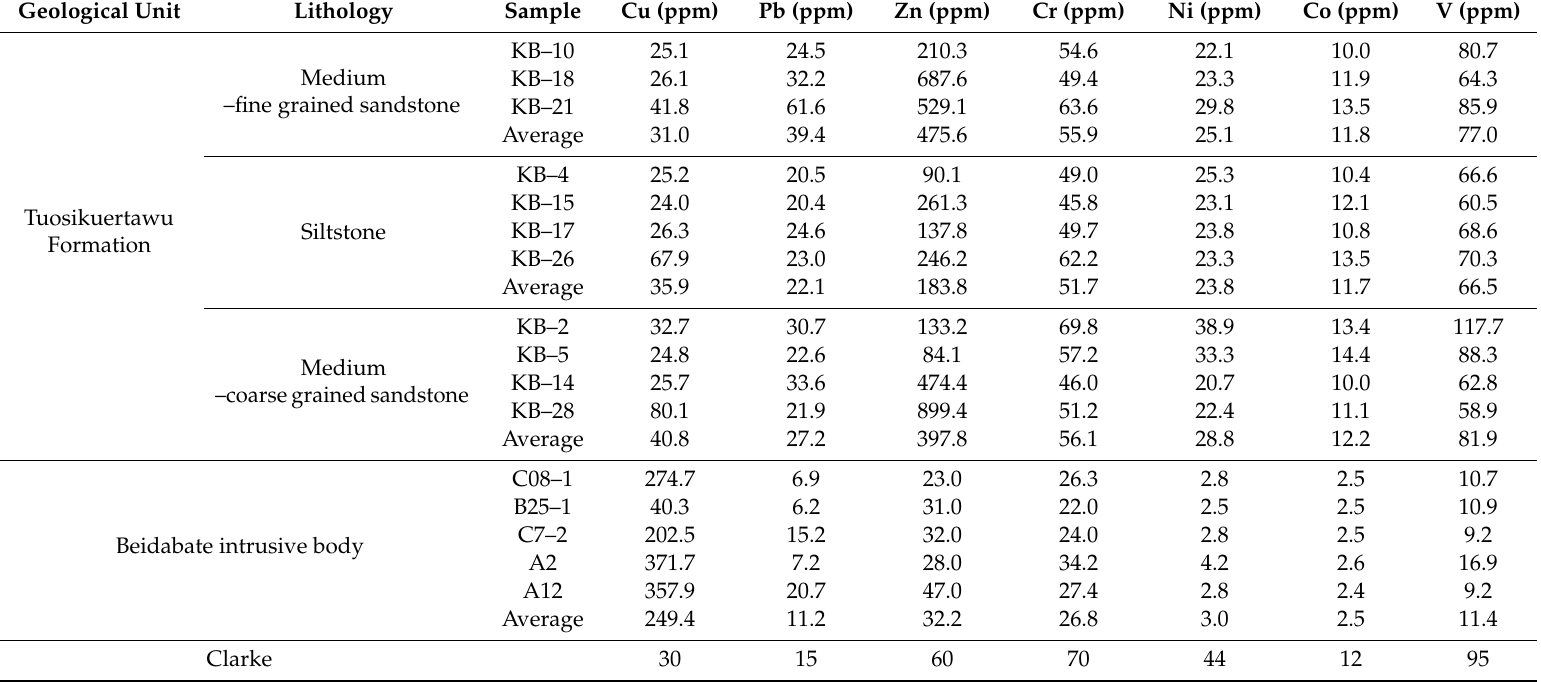
Table 5. Element abundance in lithologies of the Tuosikuertawu Formation and the Beidabate intrusive